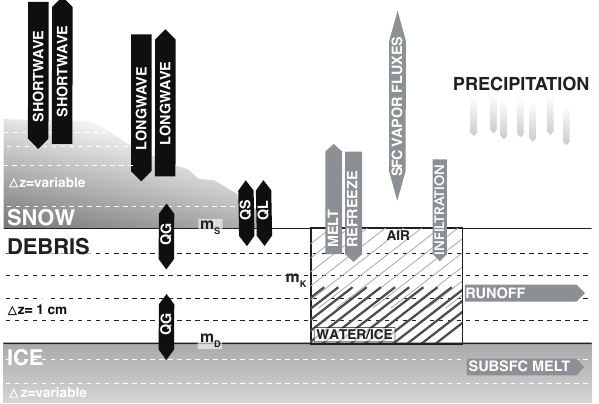
Figure 1. Schematic of the CMB-RES model and its treatment of the debris moisture content and its phase. The levels m S , m D , and m K correspond to the bottom of the snowpack, the base of the debris layer, and the level of the saturated horizon,